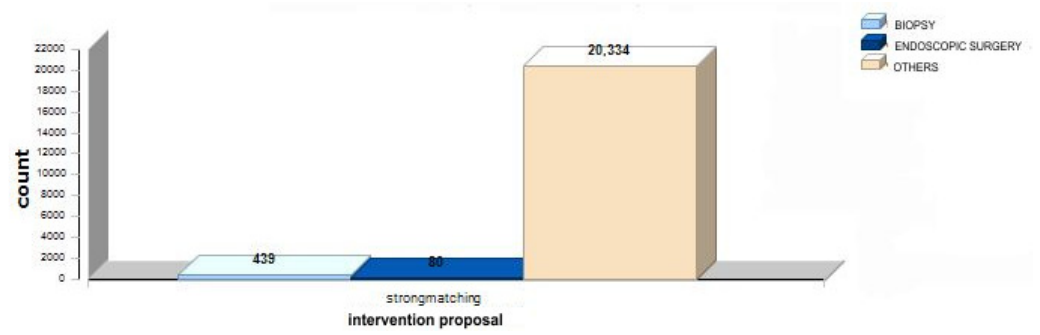
Figure 5: Result for query C={(SURGERY,ENDOSCOPIC),(BIOPSY)} (with strong matching)